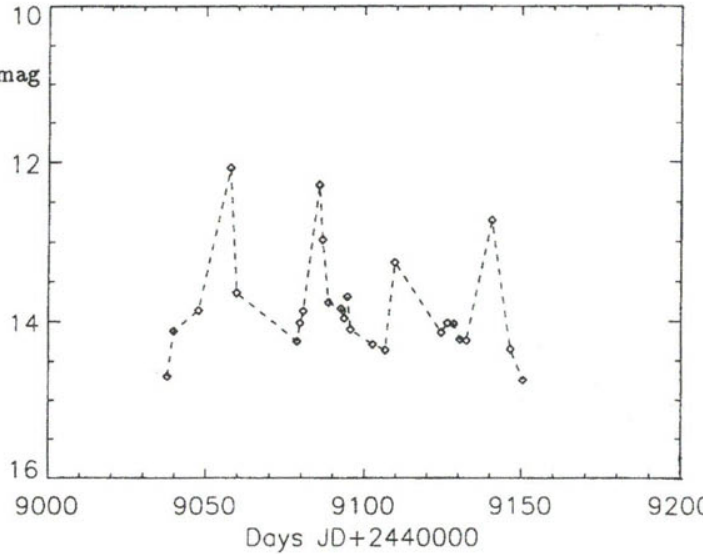
Fig. 2. Monitoring of the V magnitude of CRBoo with the CAMC at La Palma in